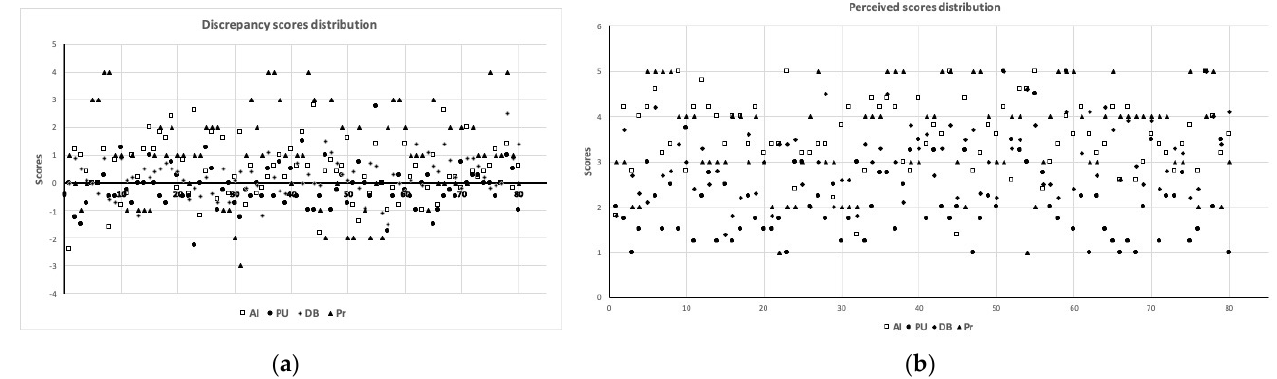
Figure 2. ( a ) Distribution of the sample discrepancy scores; ( b ) Distribution of the sample perceived scores. AI, active involvement; PU, praise and understanding; DB, directive behavior; Pr, pressure.